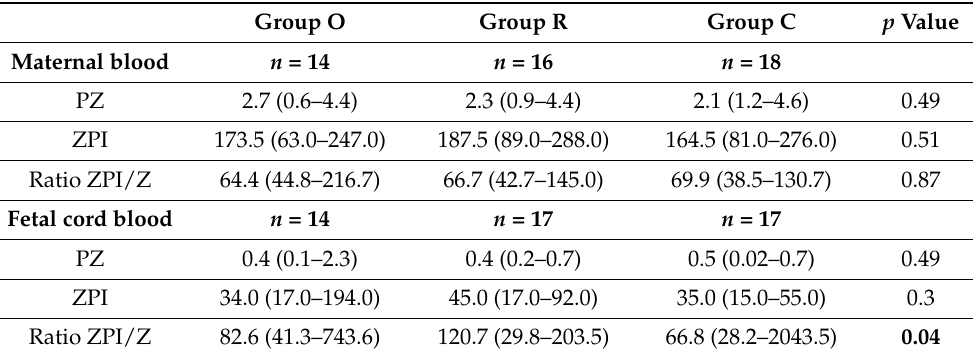
Table 3. Protein Z and ZPI